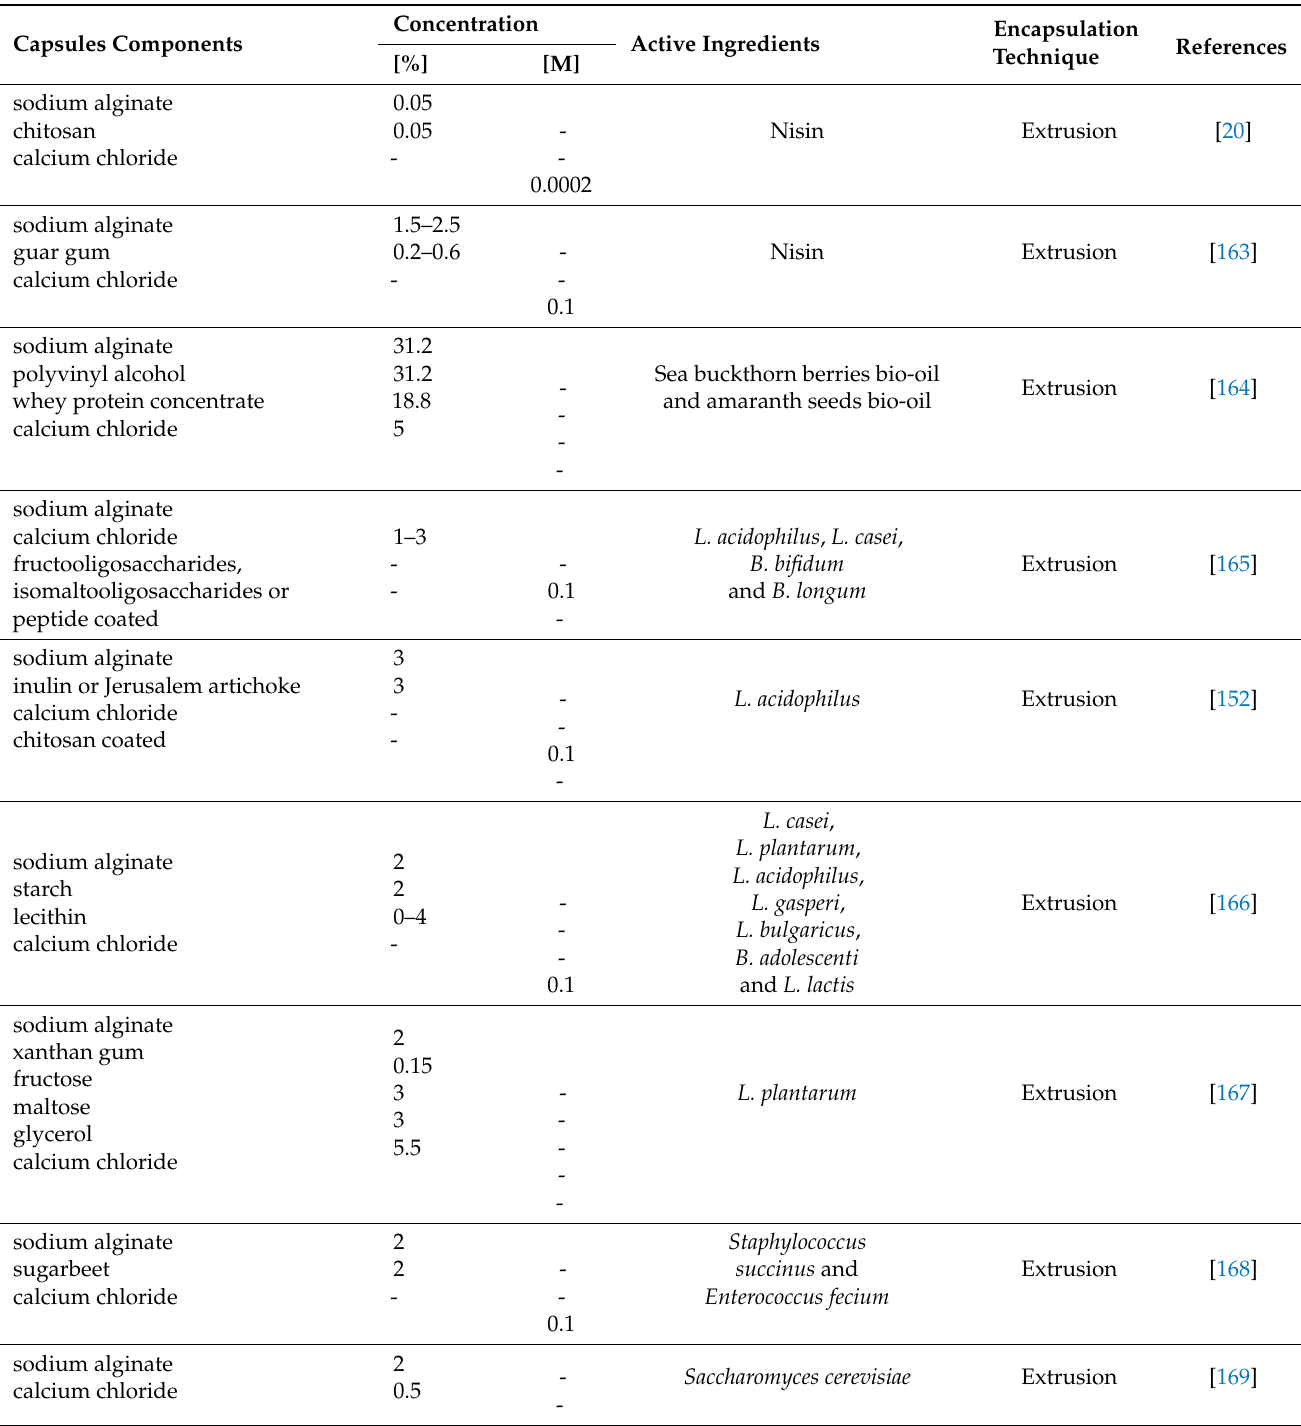
Table 3. The application of alginate carriers in the food